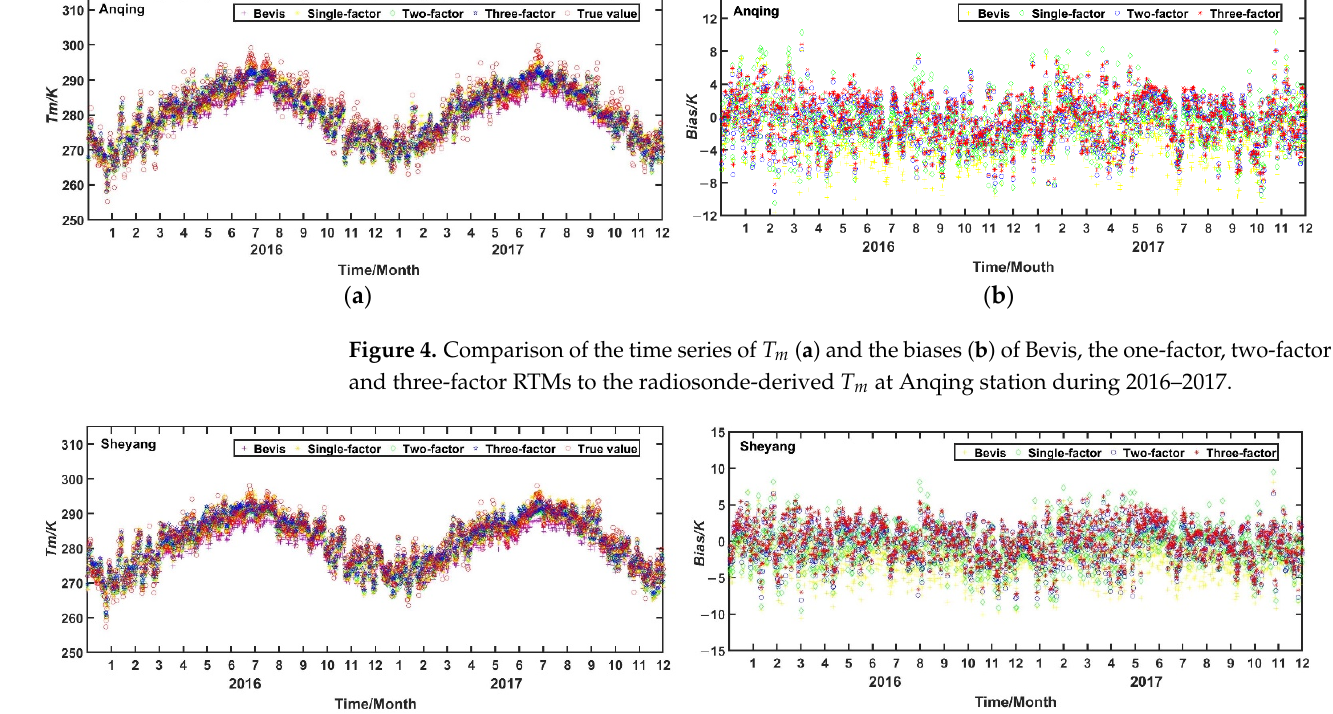
Table 5. Previous RTMs in the Yangtze River Delta [50].